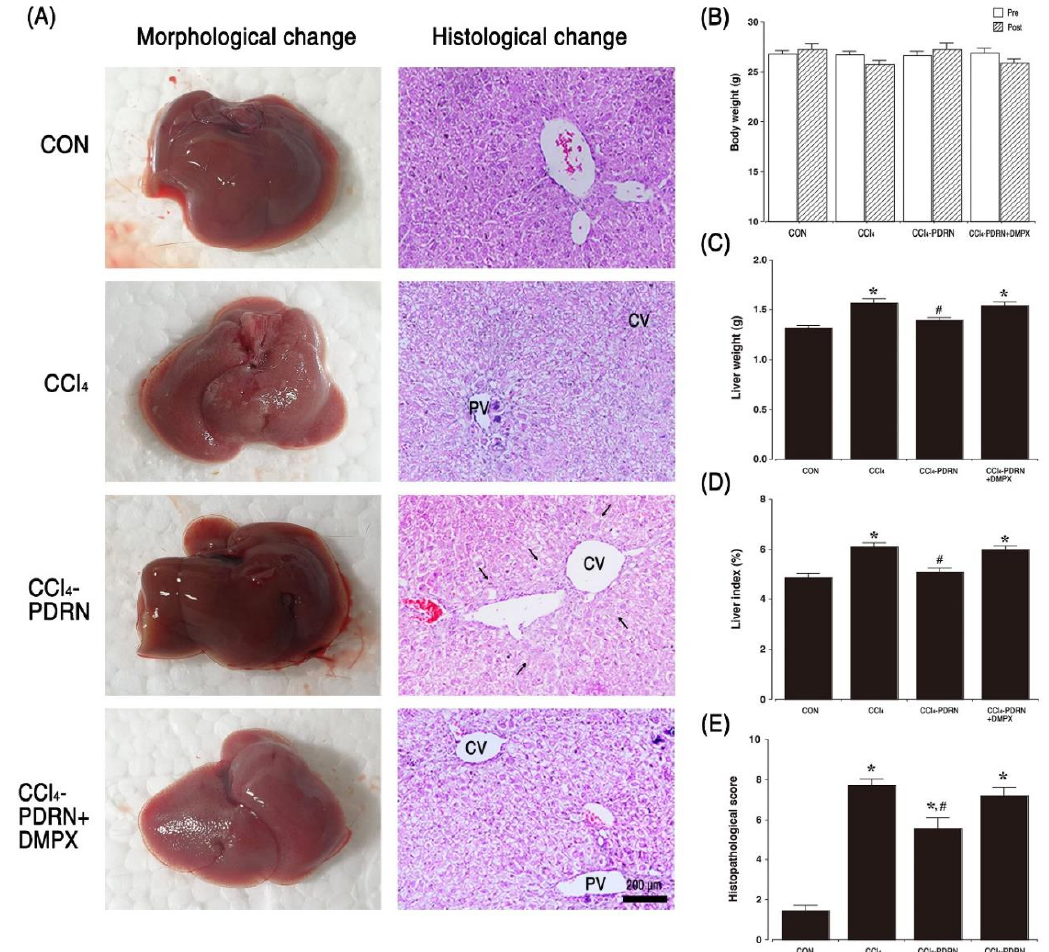
Figure 2. Change in morphology, histology, and liver index. ( A ) Morphological and histological change in the liver. ( B ) Body weight change during the experiment. ( C ) Liver weight in each group. ( D ) Liver index in each group. ( E ) Histopathological score in each group. (CV) Central vein, (PV) portal vein. Block arrows indicate recovery from hepatocyte necrosis. □: Measurement before experiment, ▨ : Measurement at the end of the experiment. CON, control group; CCl 4 , CCl 4 -injection group; CCl 4 -PDRN, CCl 4 -injection and polydeoxyribonucleotide (PDRN)-treated group; CCl 4 - PDRN+DMPX, CCl 4 -injection and PDRN with 3,7-dimethyl-1-propargylxanthine (DMPX)-treated group. * indicates p < 0.05 when compared with the control group. # indicates p < 0.05 when compared with the CCl 4 -injection group.